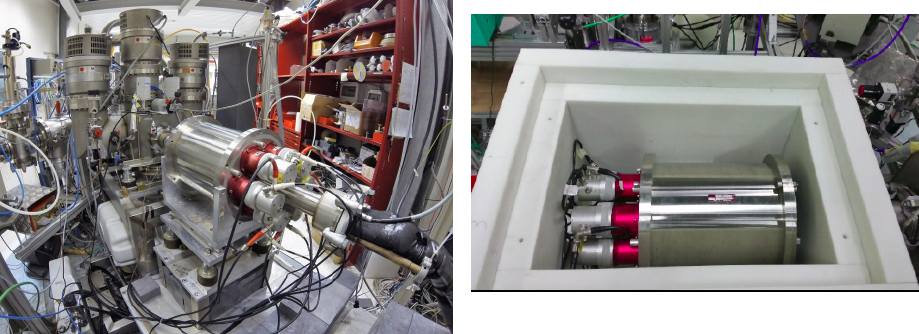
Figure 1: Setup adopted for Campaign I. Figure 2: Setup improved for Campaign II.